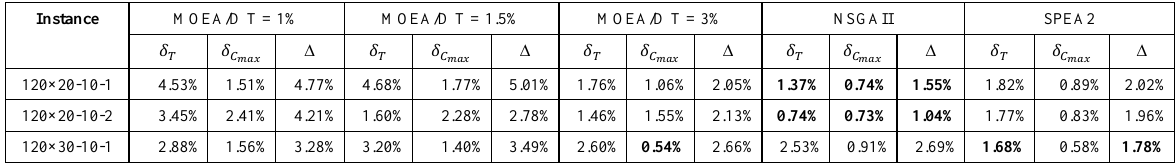
Table 8. Distance of the best trade-off solution to the ideal vector with baseline NSGAII and